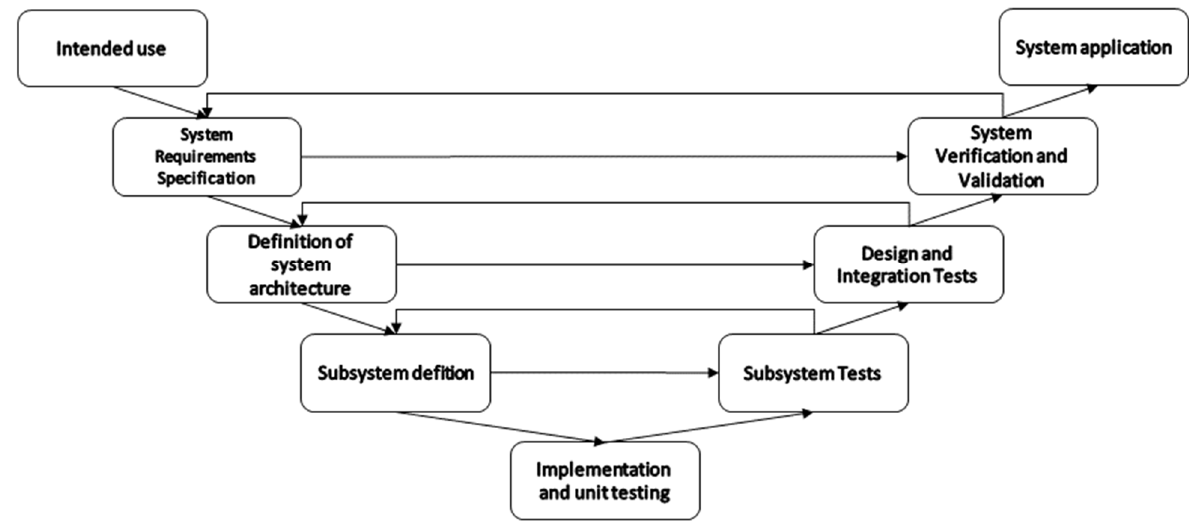
Figure 4. Graphical representation of a V ‐ Model development road map of measuring systems.